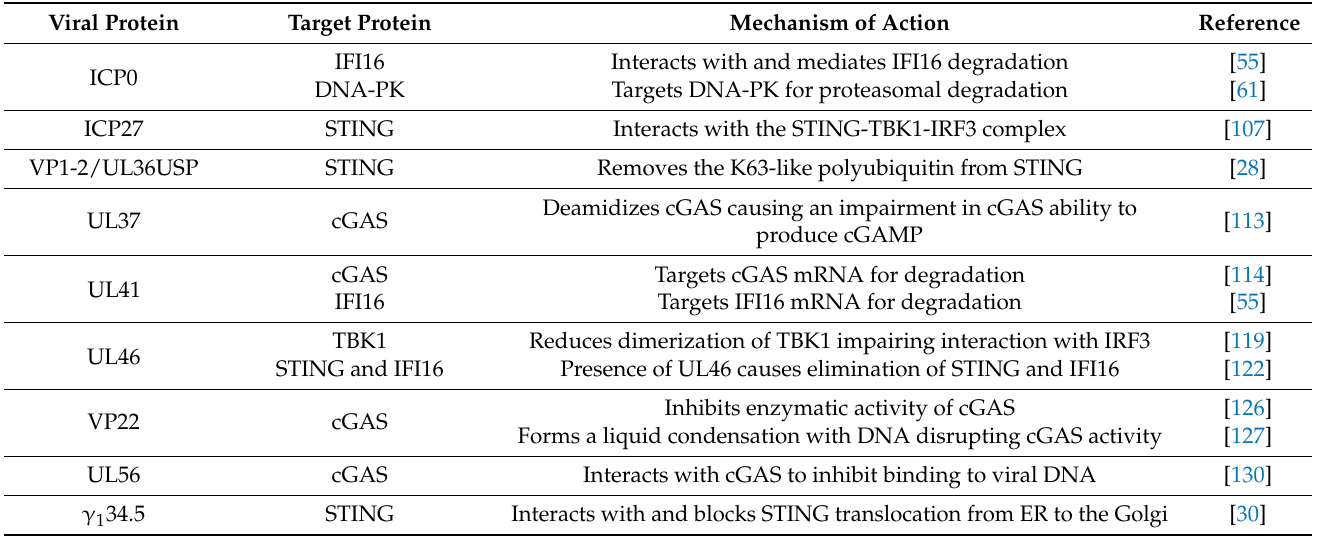
Table 1. Notable HSV antagonists of the STING